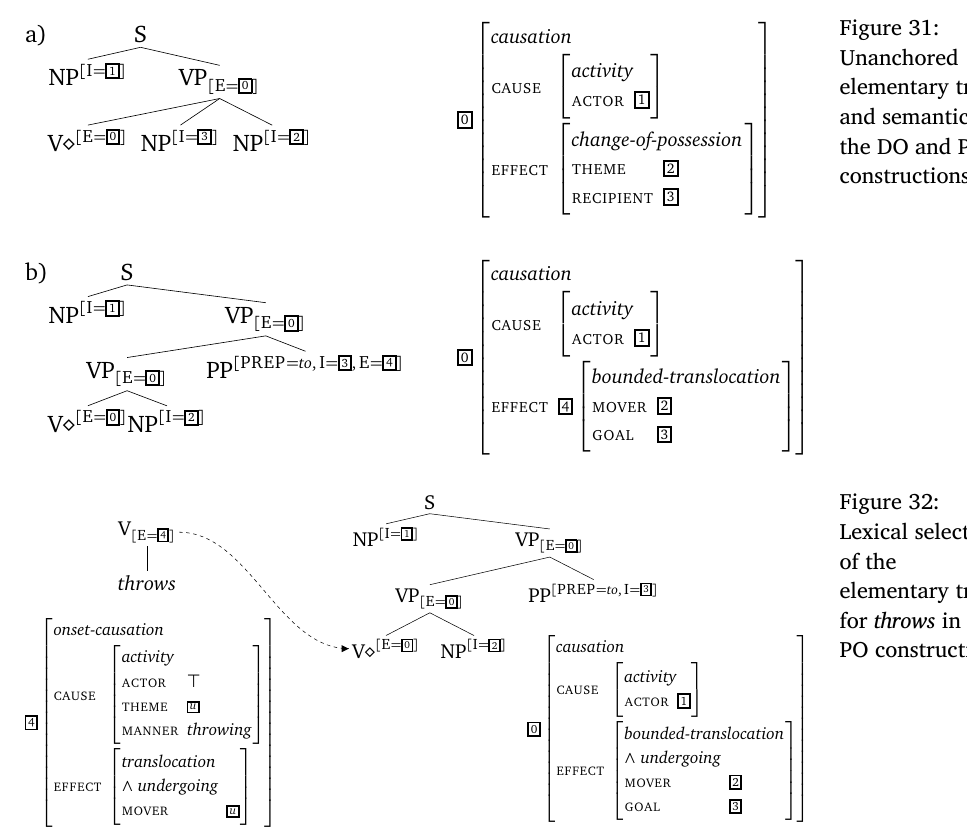
Figure 31: Unanchored elementary trees and semantics of the DO and PO constructions